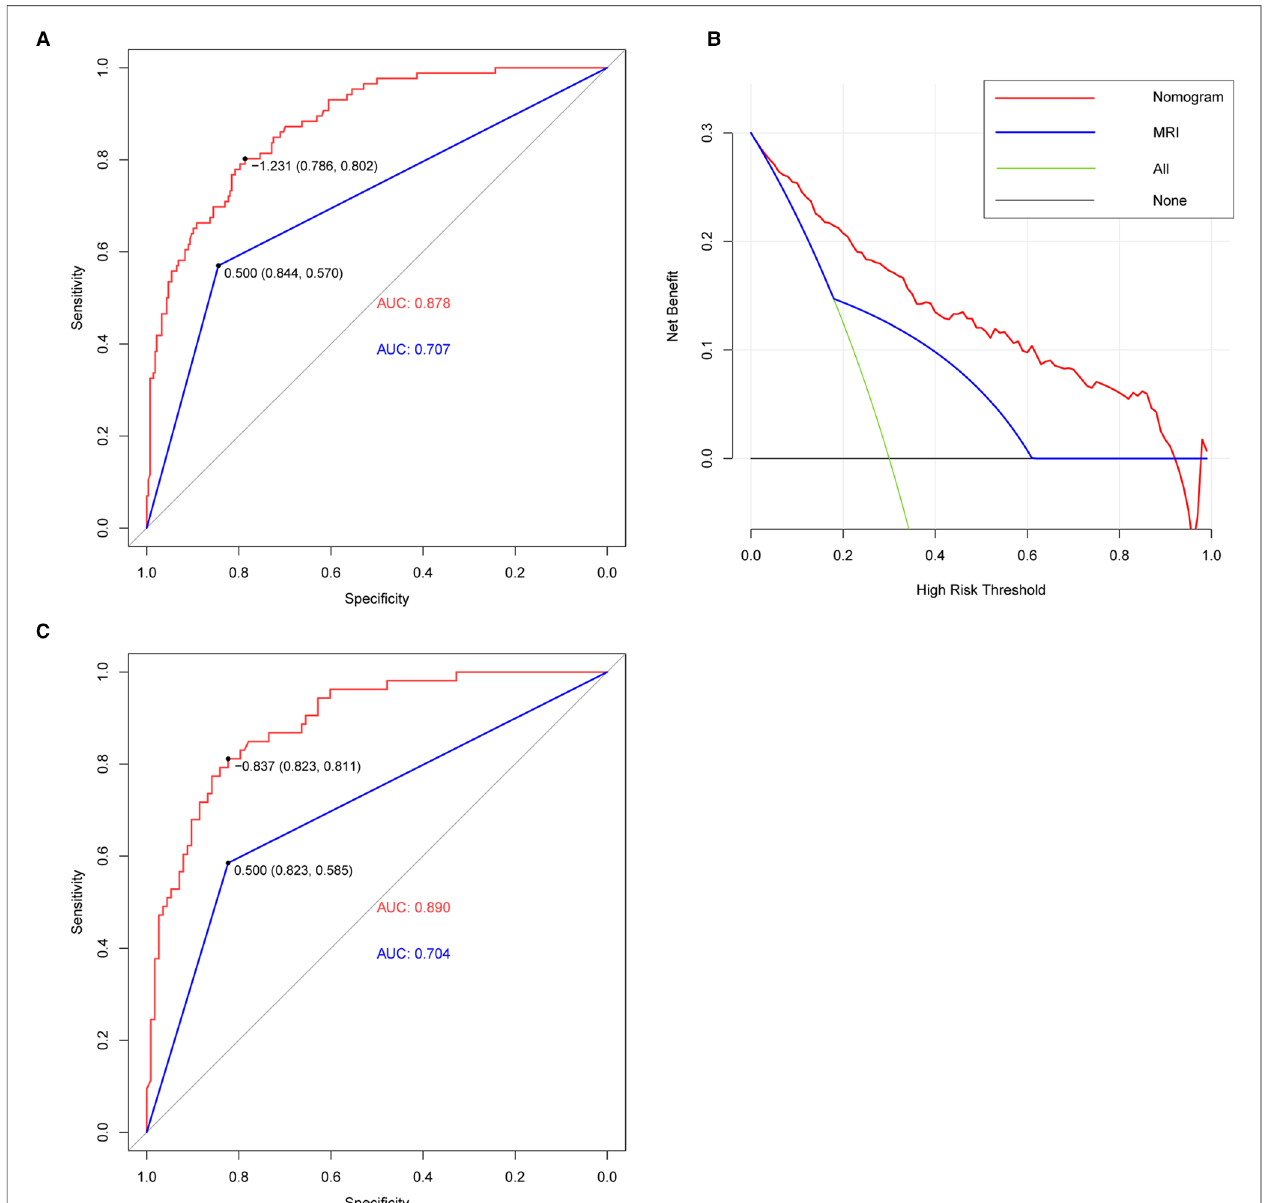
FIGURE 5 | ROC and DCA curve. ( A ) AUC of the nomogram (red line) and MRI (blue line) (nomogram: 0.878, MRI: 0.707) in the training cohort. The nomogram provided better diagnostic performance compared with MRI. ( B ) DCA of nomogram (red line) and MRI (blue line). DCA curve analysis showed that the nomogram had achieved a higher clinical application value and better clinical practicability than MRI. ( C ) AUC of nomogram (red line) and MRI (blue line) (nomogram: 0.890, MRI: 0.704) in the validation cohort. The nomogram also provided better diagnostic performance in the validation